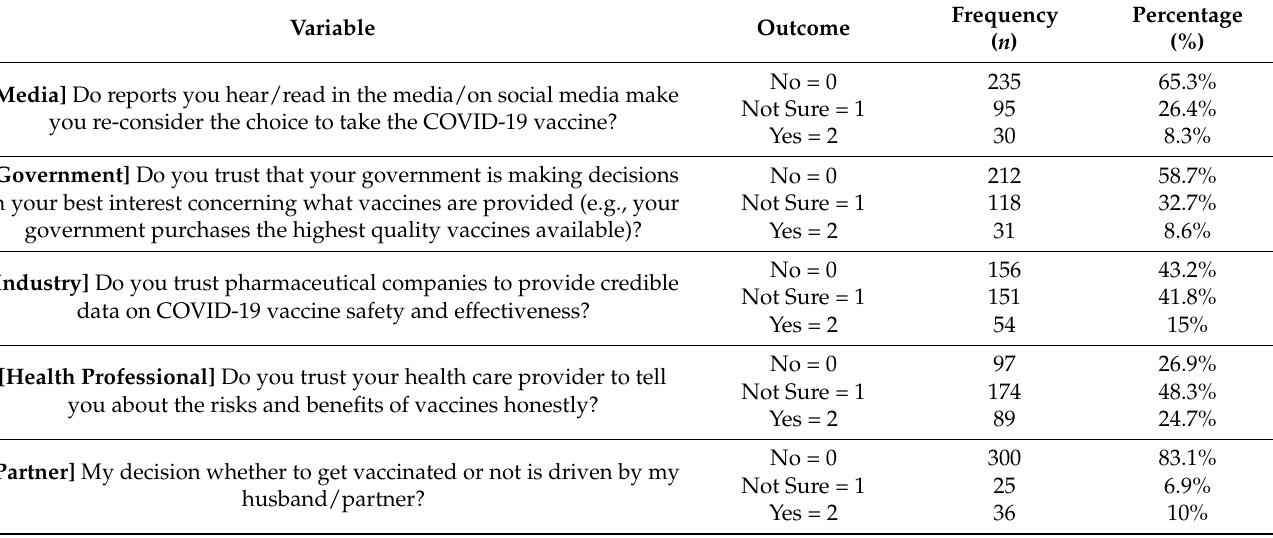
Table 6. COVID-19 vaccine-related attitude predictors of pregnant and lactating women (PLW), University Hospital Brno, August–October 2021 ( n =